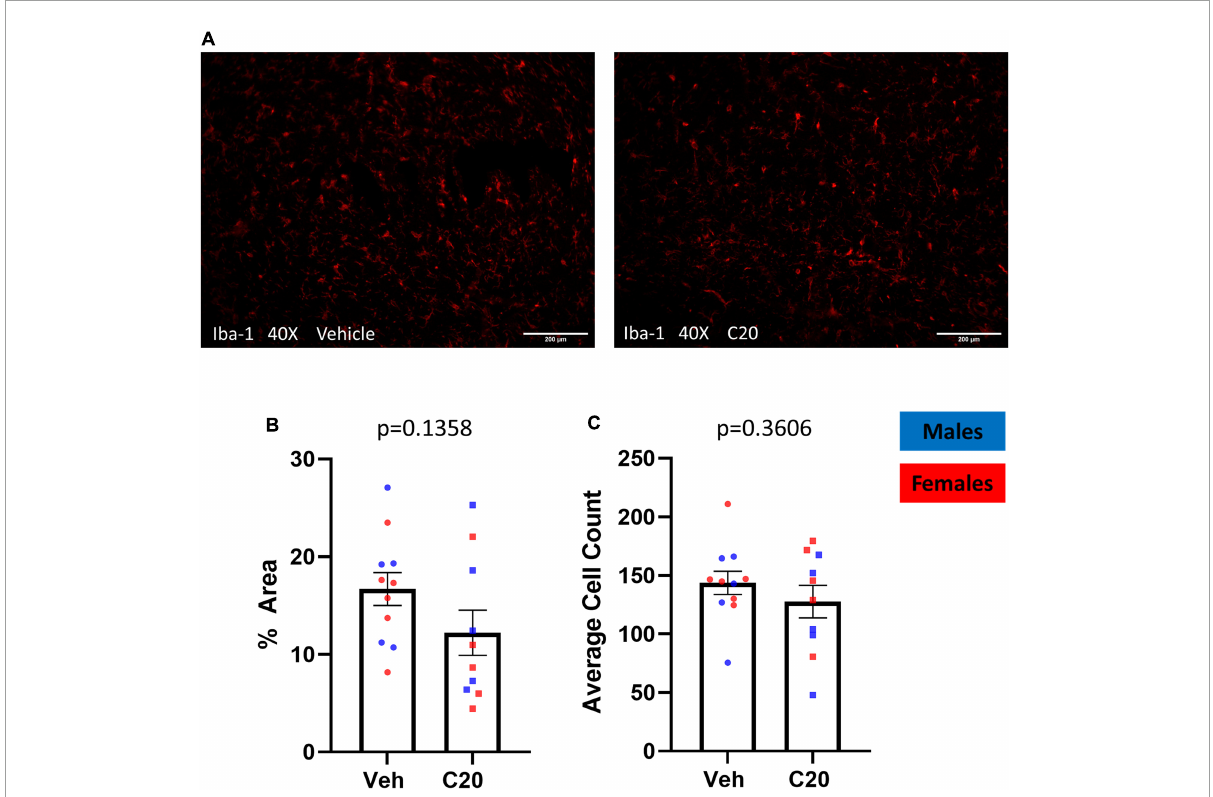
FIGURE3 The C20:0 ceramide infusions did not increase microglia in the VH. (A) Representative images of VH from vehicle-infused (left column) and ceramide-infused (right column) rats showing microglia labeled with Iba-1. (B,C) The expression of the microglial marker Iba-1 in the VH of male and female rats quantified as percent of stained area and number of positive microglia cells. N = 11 in vehicle group and n = 10 in ceramide infused groups. Males in blue symbols and females in red symbols.